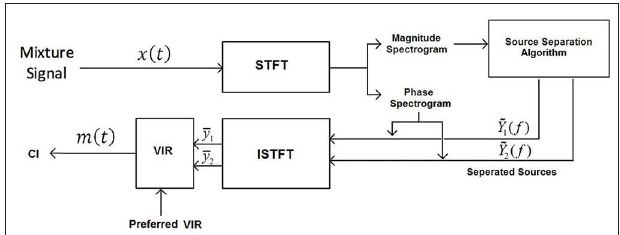
FIGURE 1 | Block diagram of the source separation